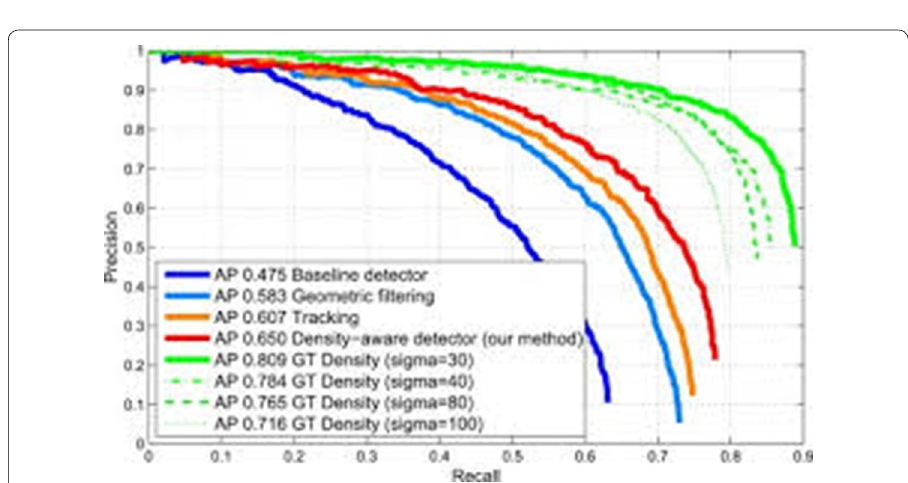
Fig. 6 Comparing detection performance of density aware detector with different methods